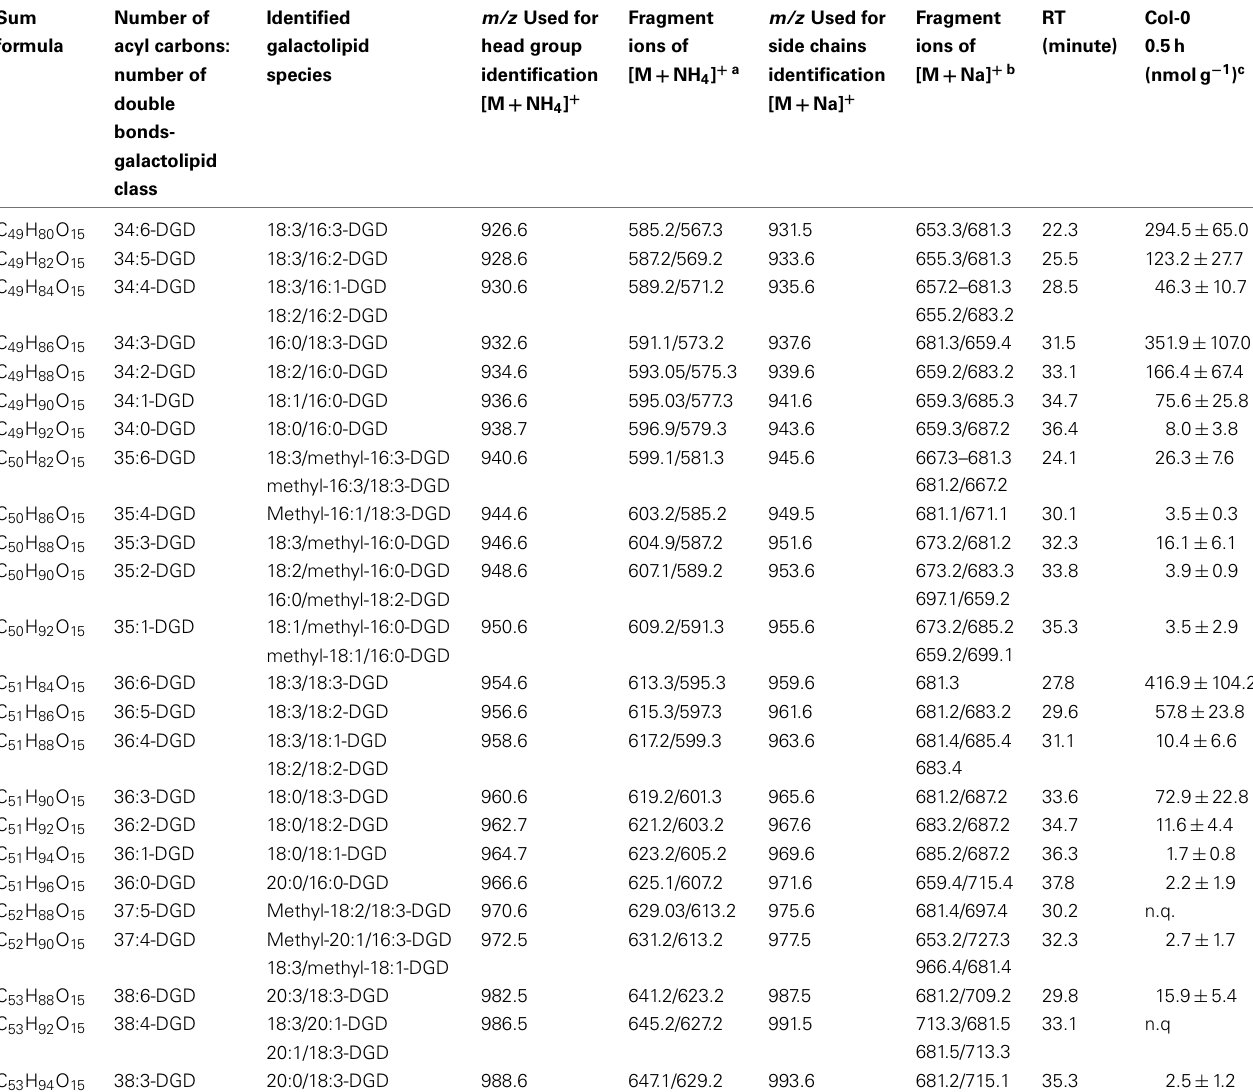
TableA3 | Non-oxidized DGD species identified in wounded A. thaliana leaves.